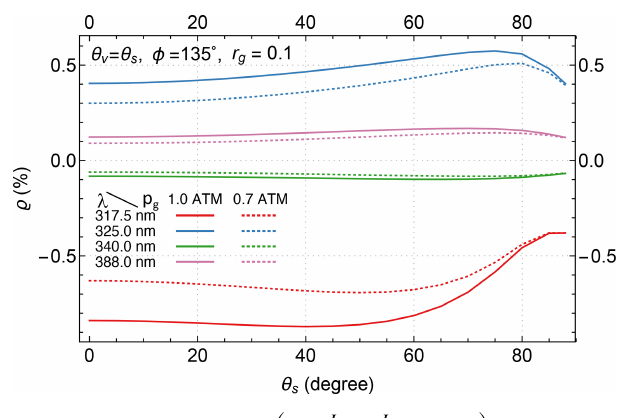
Figure 10. Filling-in factors bands as a function zenith angle at two surface pressures p g = 0 . 7ATM and p g = 1 . 0ATM, with a surface albedo of r g = 0 . 1.